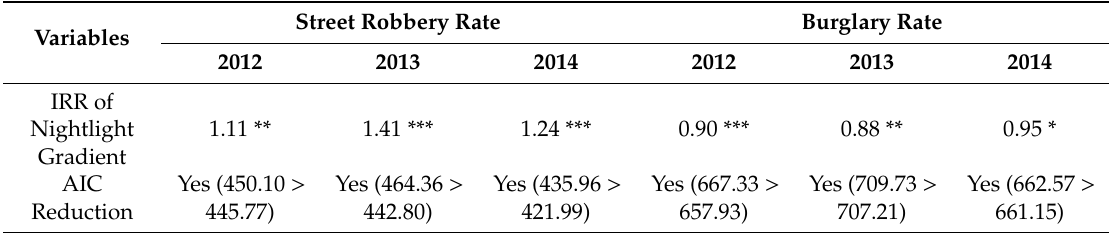
Table 6. Results of IRR of Nightlight Gradient and AIC reduction in